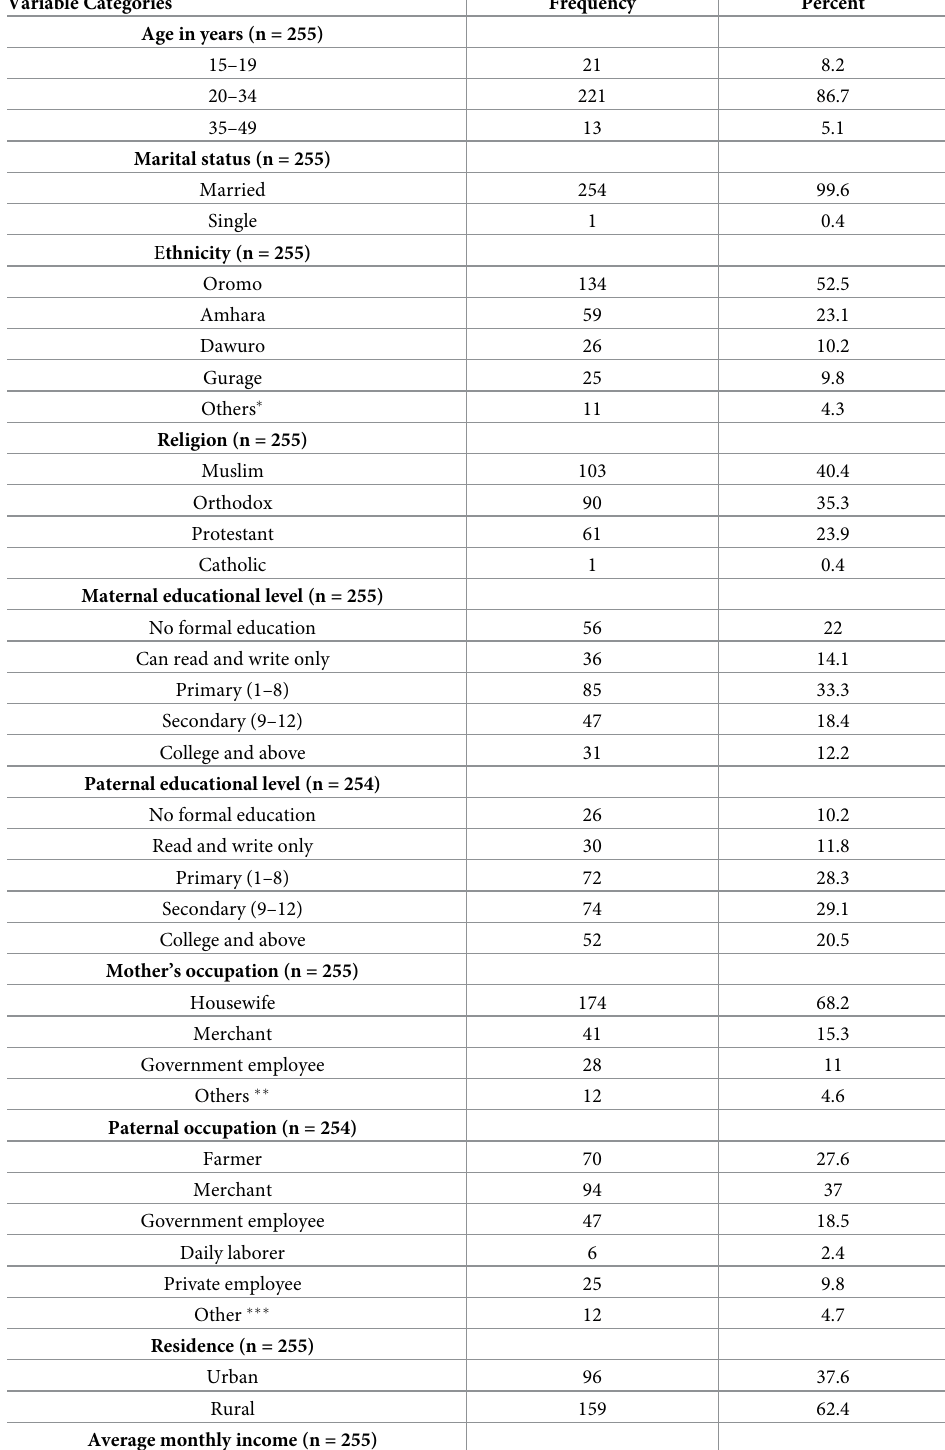
Table 1. Socio-demographic characteristic of respondents in public hospitals of Jimma zone, southwest Ethiopia,